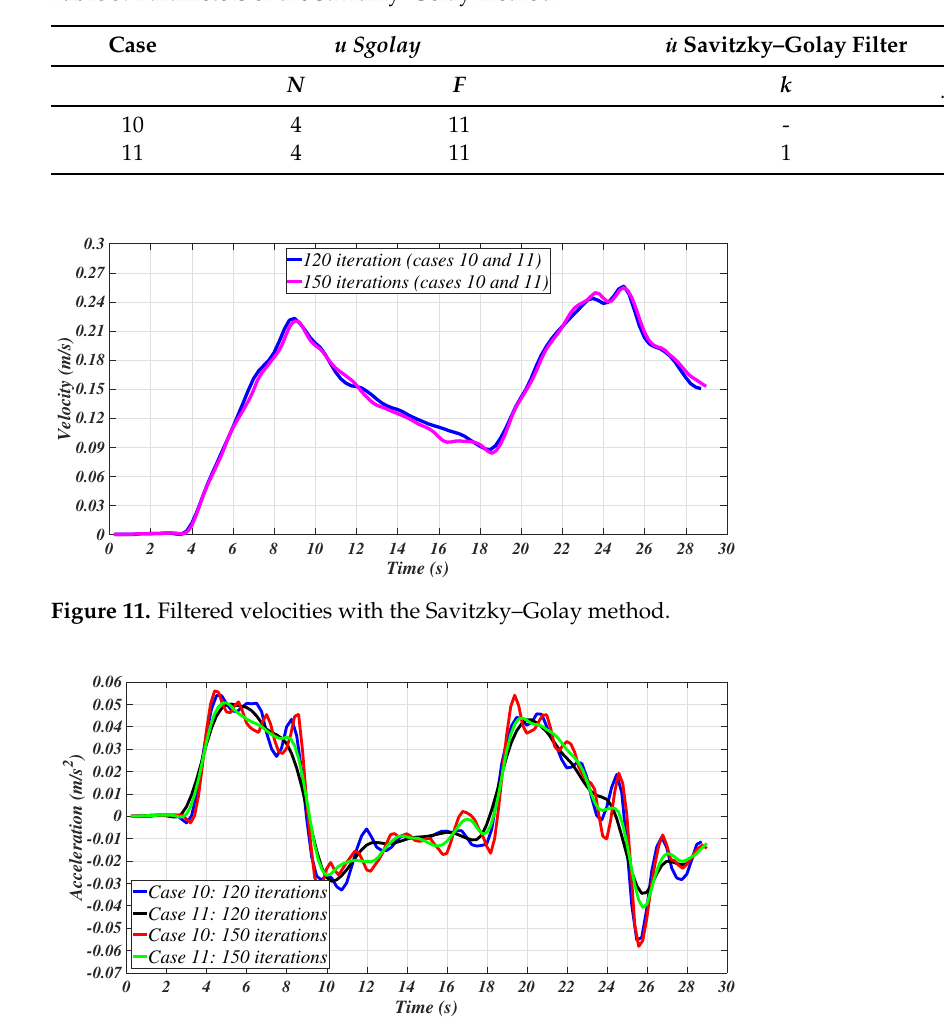
Figure 12. Filtered accelerations for cases 10 and